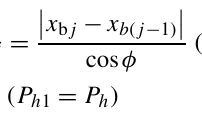
Figure 10. Geometric